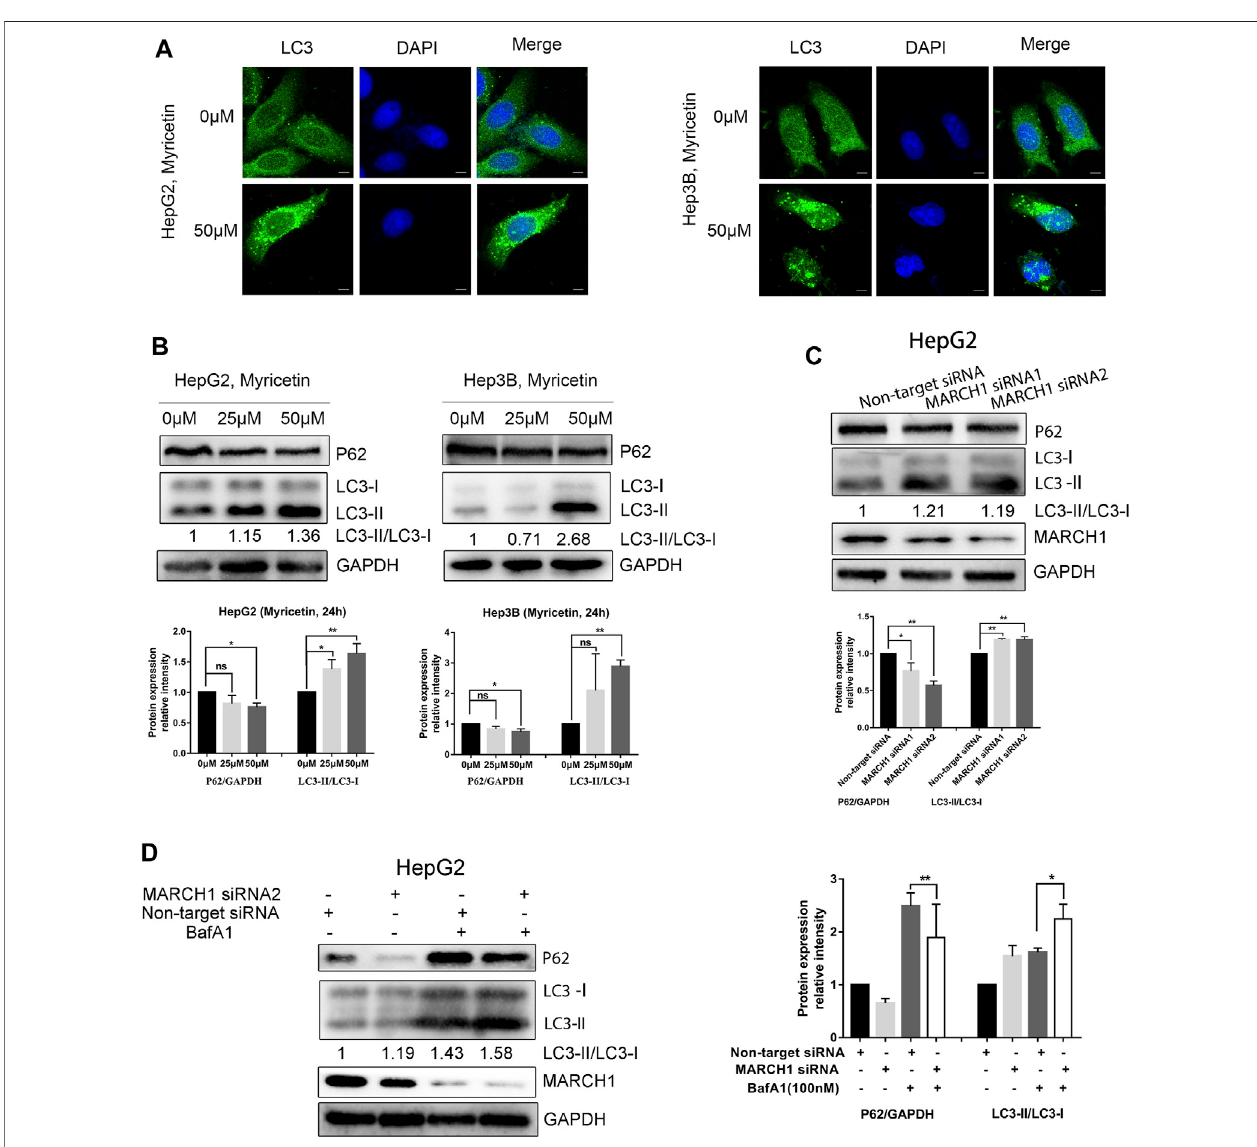
FIGURE2|MyricetininducesautophagyofHCCcellsbydownregulatingMARCH1.(A) Immuno fl uorescencestainingusedtodetecttheendogenousLC3 punta to assess autophagy activity of HCC cells treated with myricetin, bar: 10 μ m. (B) The expression of autophagy marker proteins LC3 and P62 detected by immunoblotting in HCC cells treated with indicated doses of myricetin for 24 h (C) LC3 and P62 expression in HepG2 cells transfected with or without siRNA MARCH1 analyzedbyWesternblot. (D) HepG2cells,transfectedwithsiRNAsandmixedwithorwithout100 nMBafA1,wereincubatedfor48 h.TheexpressionofLC3and P62 measured by immunoblotting. Band intensity determined by ImageJ. All data are from the results of the three experiments, presented as the means ± SD. * represents p < 0.05, ** represents p < 0.01.